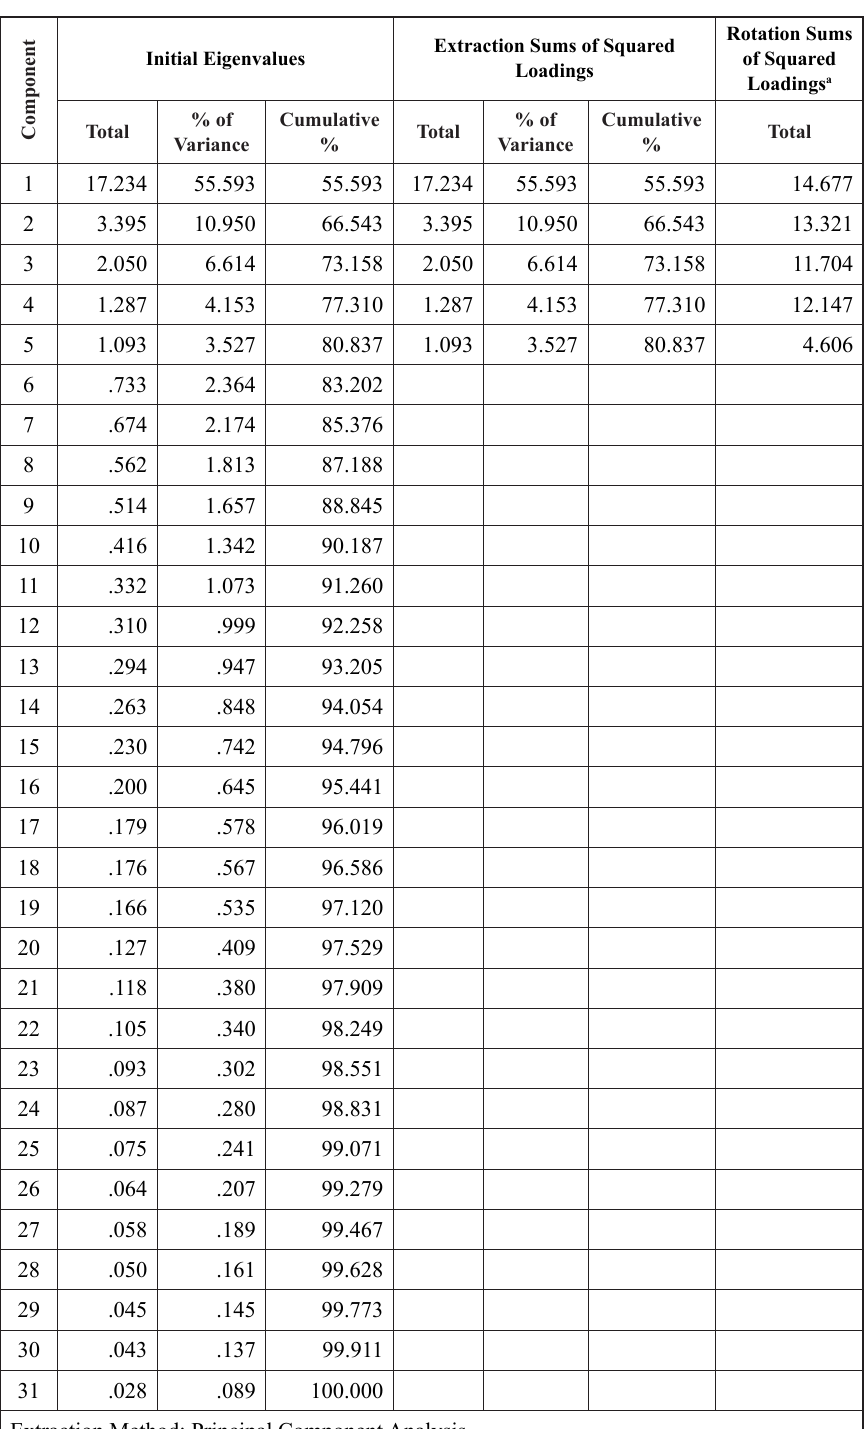
Table 3. Total explained